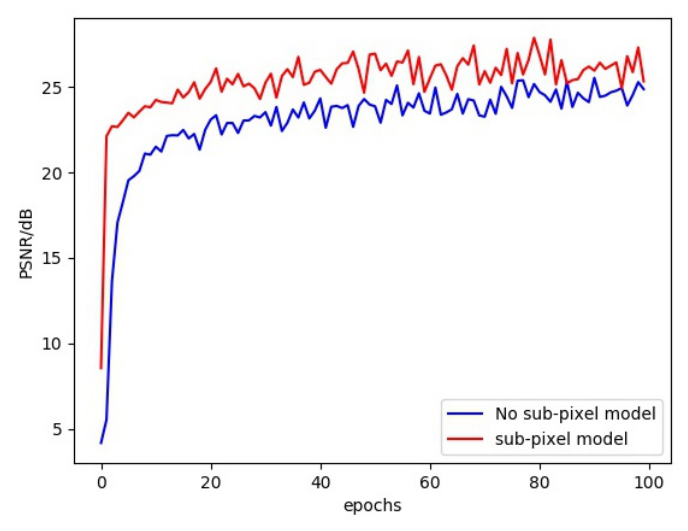
Figure 6. Performance of sub-pixel model in feature extraction. (blue curve represents no sub-pixel model, red curve represents sub-pixel